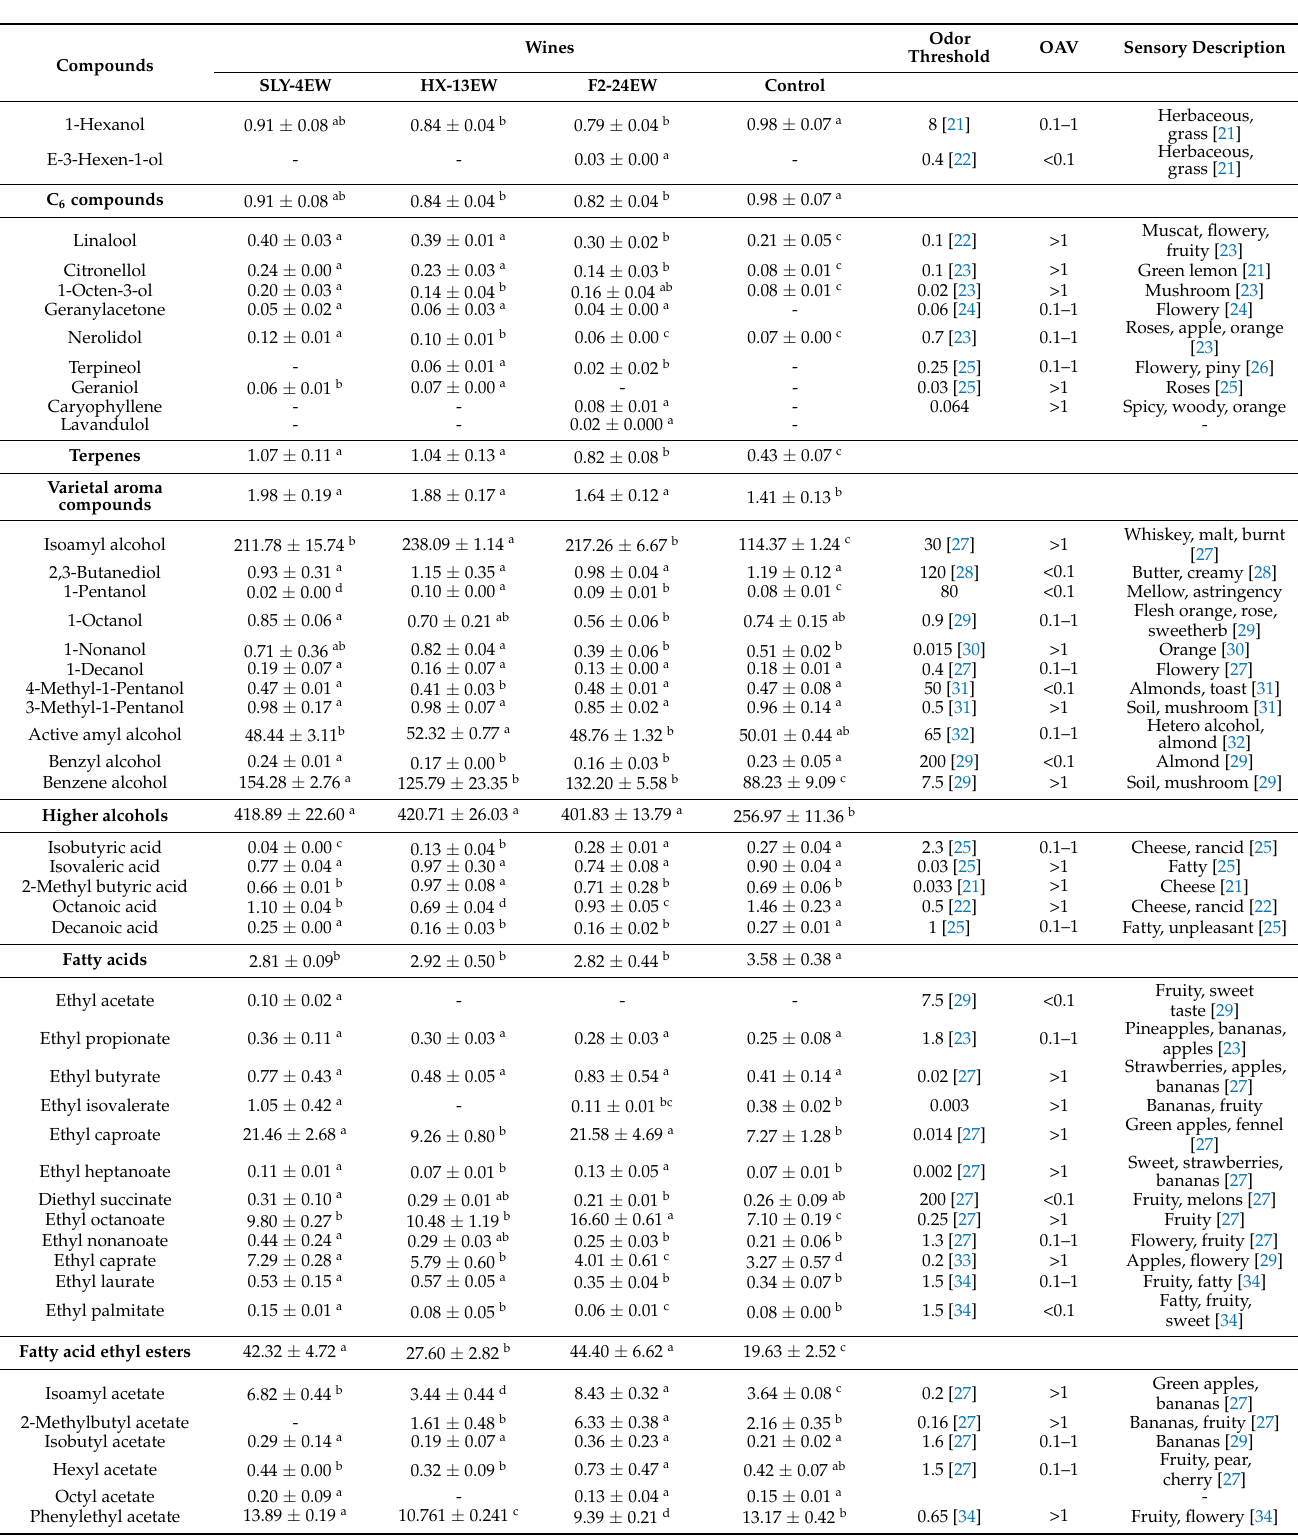
Table 2. Concentration of volatile aroma compounds in wines